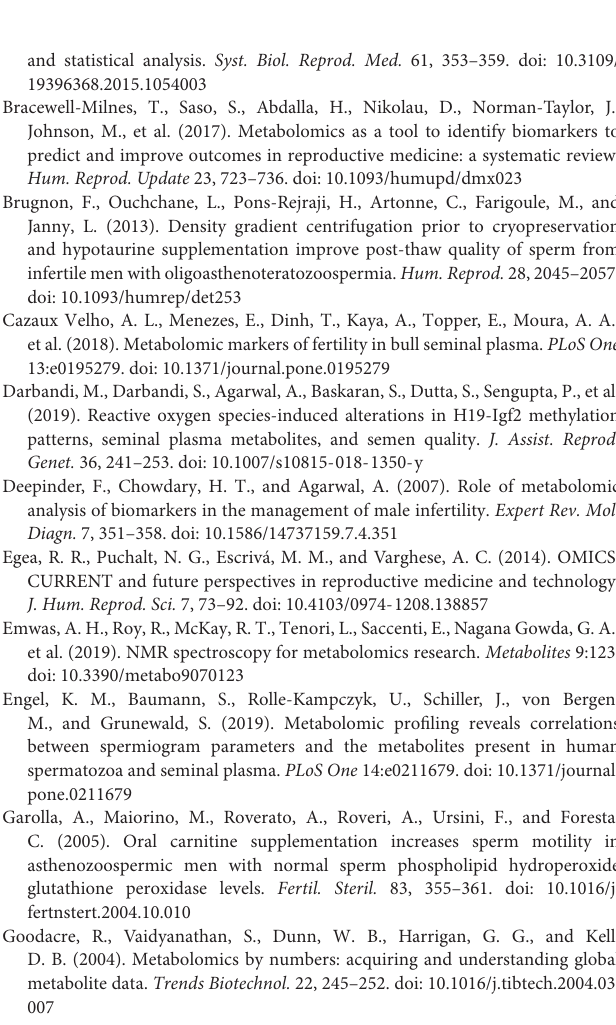
Supplementary Figure 1 | (A-M) . Complete Bayesian multiple linear regression models for all the parameters evaluated immediately after semen collection. Supplementary Figure 2 | (A-F) Complete Bayesian multiple linear regression models for all the parameters evaluated immediately after semen collection. (G,H) Complete Bayesian logistic regression models for percentages of viable sperm with high membrane destabilization, and with high intracellular Ros. Supplementary Table 1 | Metabolite concentrations (mM) in seminal plasma of Pietrain and Duroc breeds. Significant correlations ( P < 0.05 ) are marked with ∗ . Supplementary Table 2 | Sperm quality and functionality parameters of pig semen samples ( n = 28 ) assessed immediately after semen collection. Sd: Standard